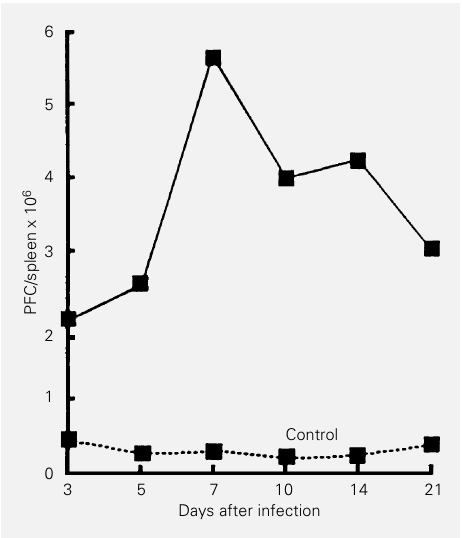
Figure 1 - Number of plaque- forming cells (PFC) of total Ig present in the spleen of control mice and mice infected with 1.2 x 10 8 cells/ml of Y. enterocolitica O:3. Results are reported as the average values of plaque-form- ing cells/spleen for 5 mice in each group. The standard devia- tion was always less than 25% of the observed